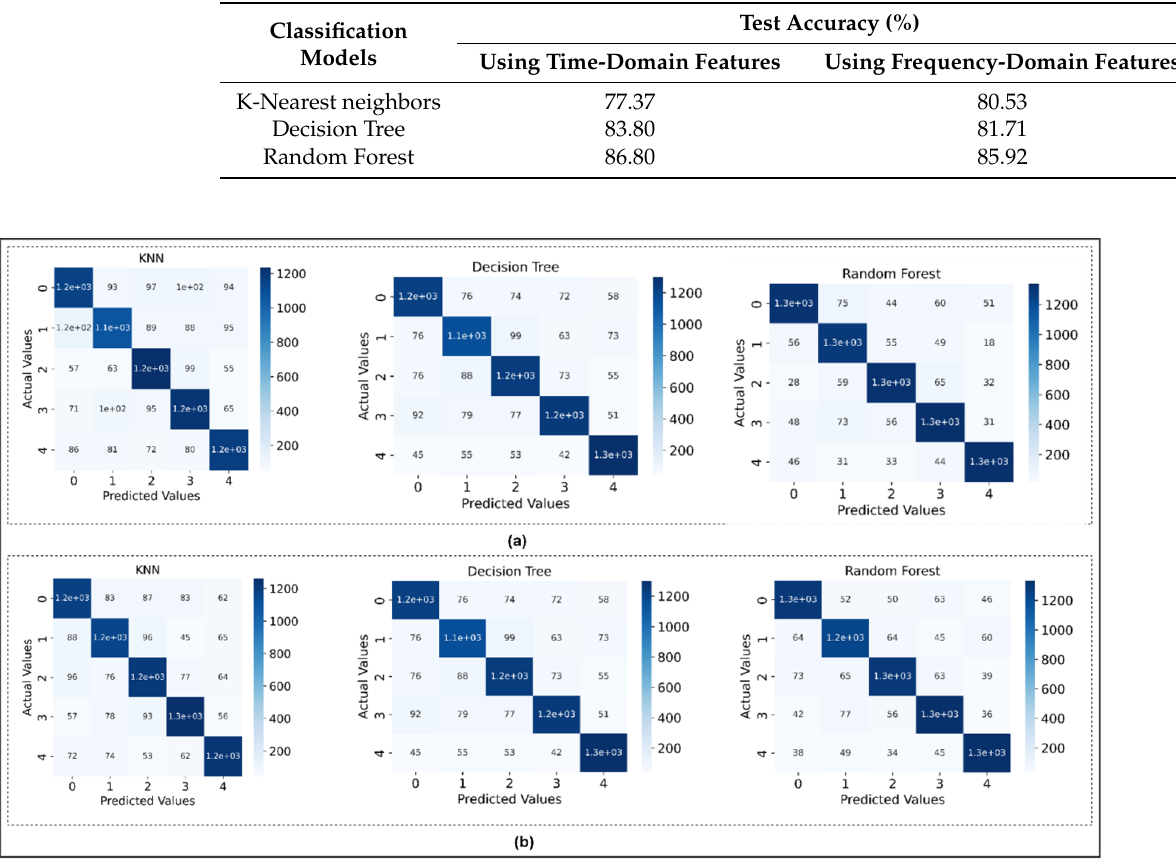
Figure 9. Confusion matrix plotted for models trained on ( a ) time domain features and, ( b ) frequency domain features. Table 2. Performance measures and comparison of different algorithms for time domain and fre- quency domain features.